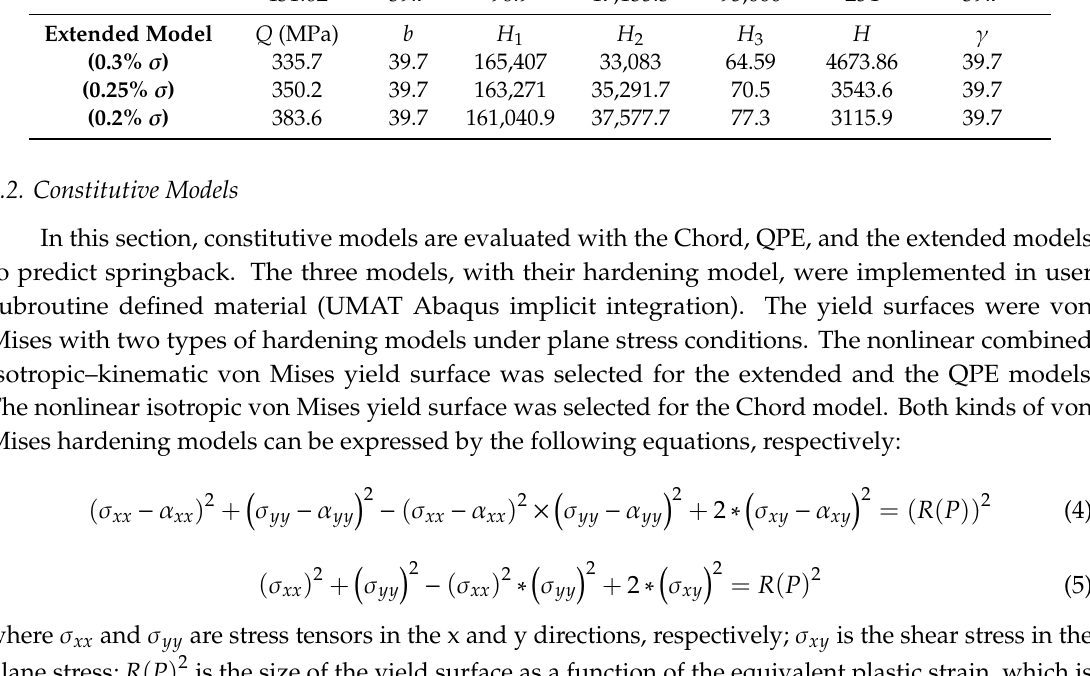
Table 1. Mechanical properties of DP780 parameters of the varies elastic models and hardening models. E 0 (MPa) ν σ UTS (MPa) σ Y (MPa) DP780 198,800 0.3 944 454 Q b E a (MPa) Chord Model 460.7 Q B (MPa) QPE Model